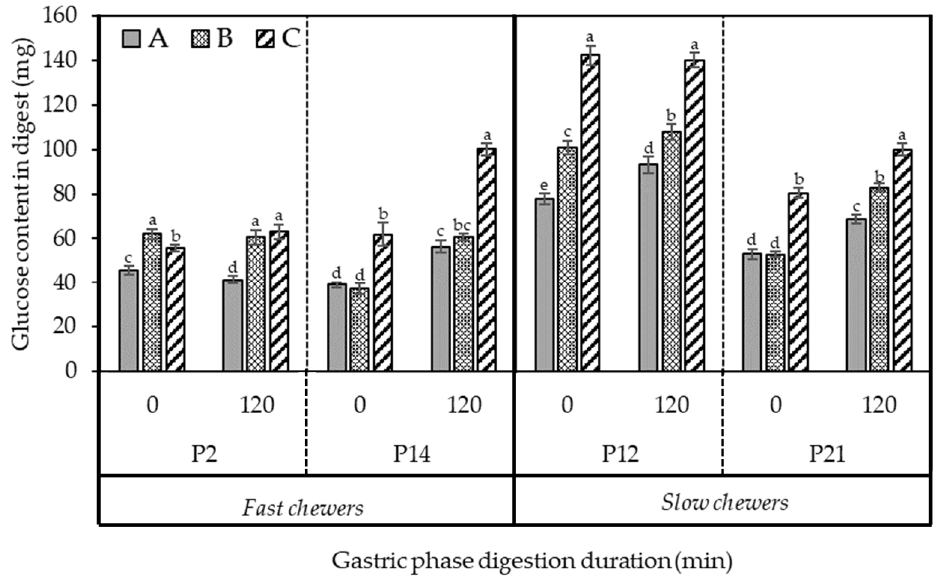
Figure 8. In vitro gastric starch digestion of in vivo masticated black bean samples (A: PEF and thermally processed without CaCl 2 addition; B: PEF and thermally processed with CaCl 2 addition; and C: No PEF, thermally processed with CaCl 2 ) from selected fast and slow chewers. Data presented as mean ± standard deviation ( n = 8 measurements). Values with different letters within each participant are significantly different ( p < 0.05) with increasing digestion time.